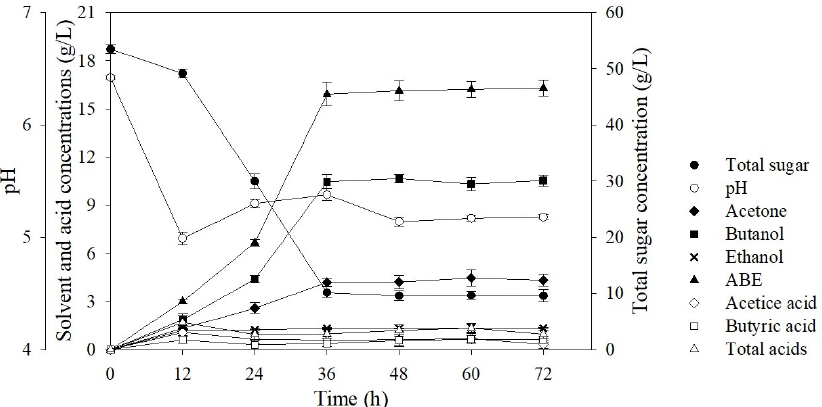
Figure 4. Profiles of ABE fermentation from the sugarcane molasses supplemented with DSY by C. beijerinckii TISTR 1461 in a 2-L stirred tank bioreactor. C. beijerinckii TISTR 1461 in a 2-L stirred tank